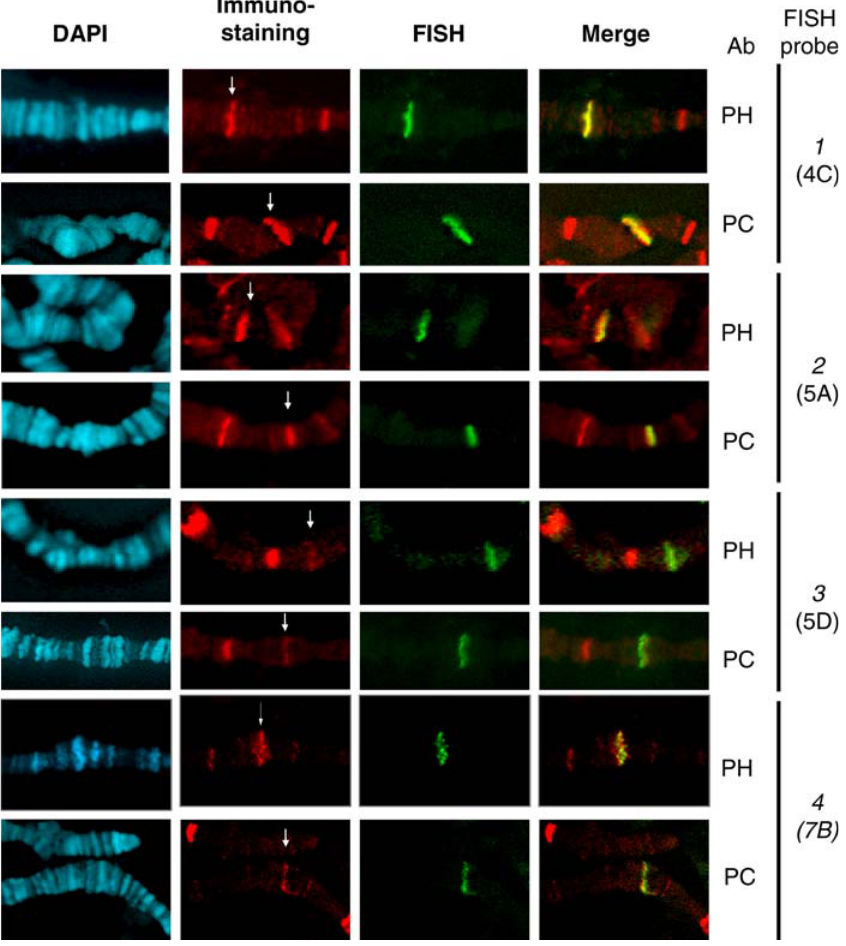
Figure 3. Immuno-FISH Mapping of PcG Protein Binding at Four Different Target Loci DAPI labeling of DNA is shown in light blue. The immunostainings of PC and PH (as indicated to the right of each row) are shown in red. DNA FISH staining is shown in green, and the merge of the red and the green channels is shown in right panels. The name and cytological position for each probe is indicated on the right. The numbers identifying the probes used correspond to those indicated in Figure 2. 1 corresponds to the bifid gene locus, 2 to the CG4136 locus, 3 to the mab-2 locus, and 4 to the cut locus. The arrows point to the bands that co-localize with the FISH signal. DOI: